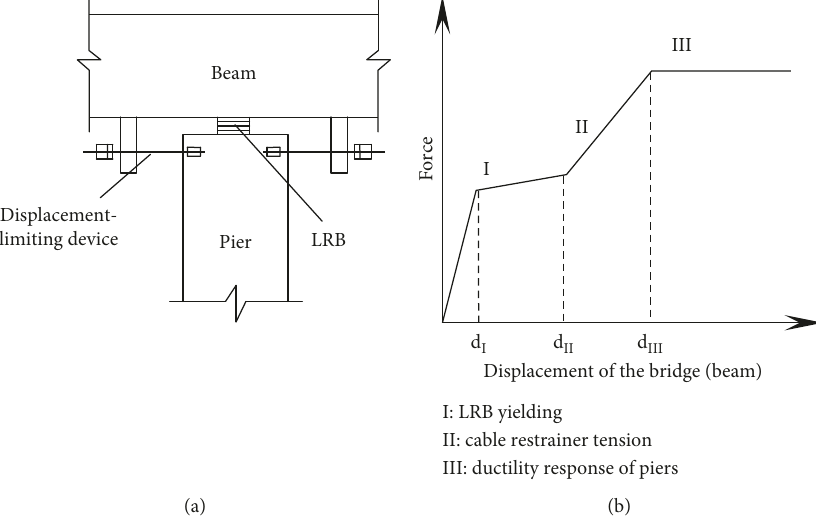
Figure 2: Scheme of the combined isolation system. (a) Combined isolation system. (b) Restoring force and displacement response schematic.